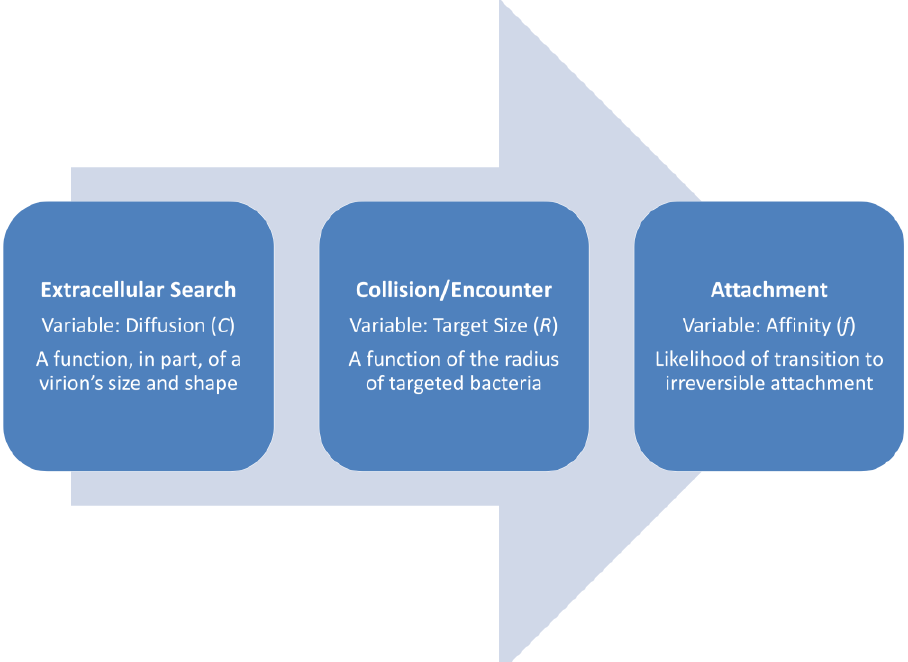
Figure 3. Factors impacting phage adsorption rates, diffusion through irreversible attachment. Variables are as introduced in Section 2.2 and Table 1. Together, they serve to determine a phage’s adsorption rate constant ( k ) for a given bacterium under a specific set of conditions.